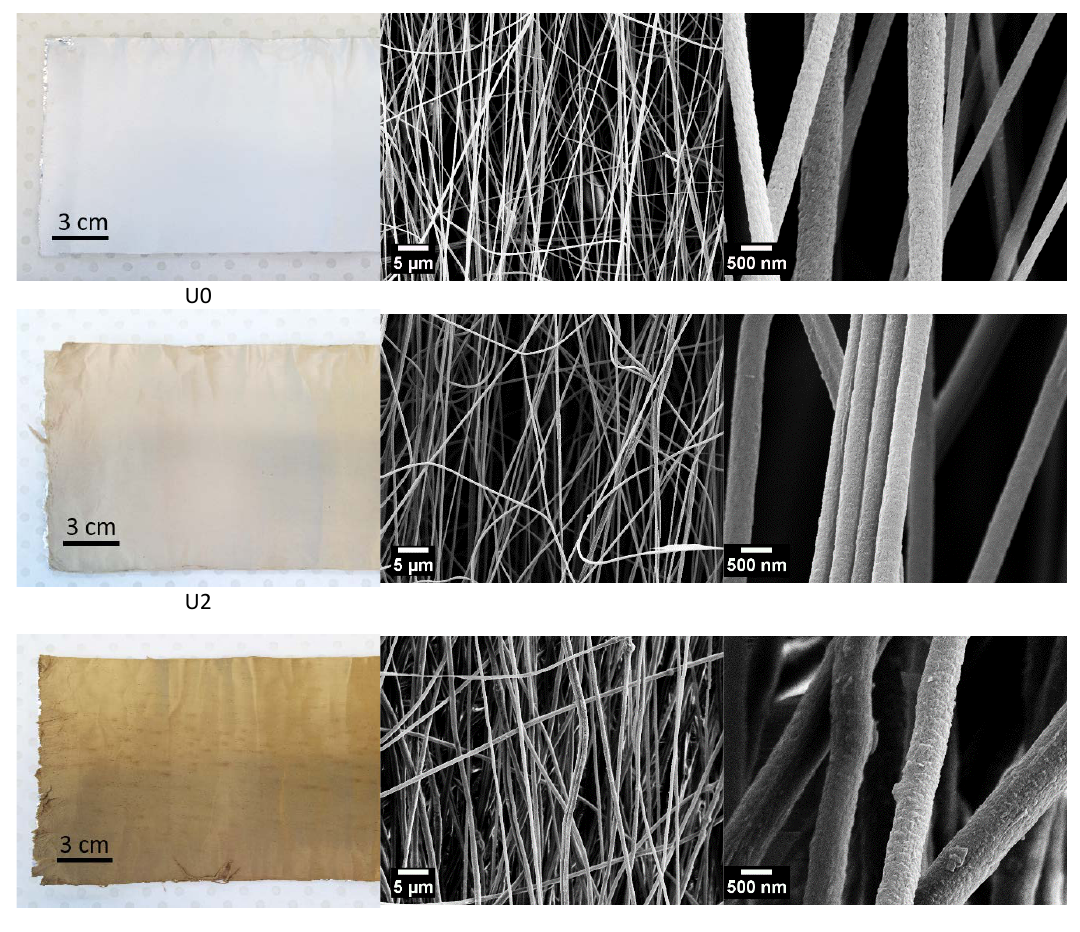
Figure 3. Left column: optical images of fibre samples, middle column: scanning electron microscopy (SEM) images of samples at low magnification and right column: SEM images of samples at high magnification for 0% (U0), 25% (U2) and 50% (U4) CTP in rows 1, 2 and 3, respectively. As the amount of CTP in PAN increases, the colour of the fibre mats turn to gold-brown and the stack of fibres became